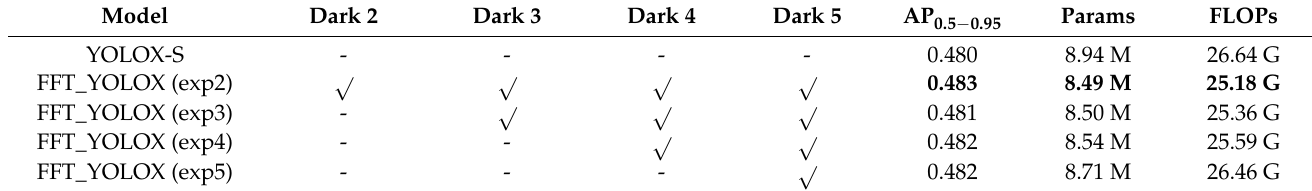
Table 3. The detail performances of ablation study.